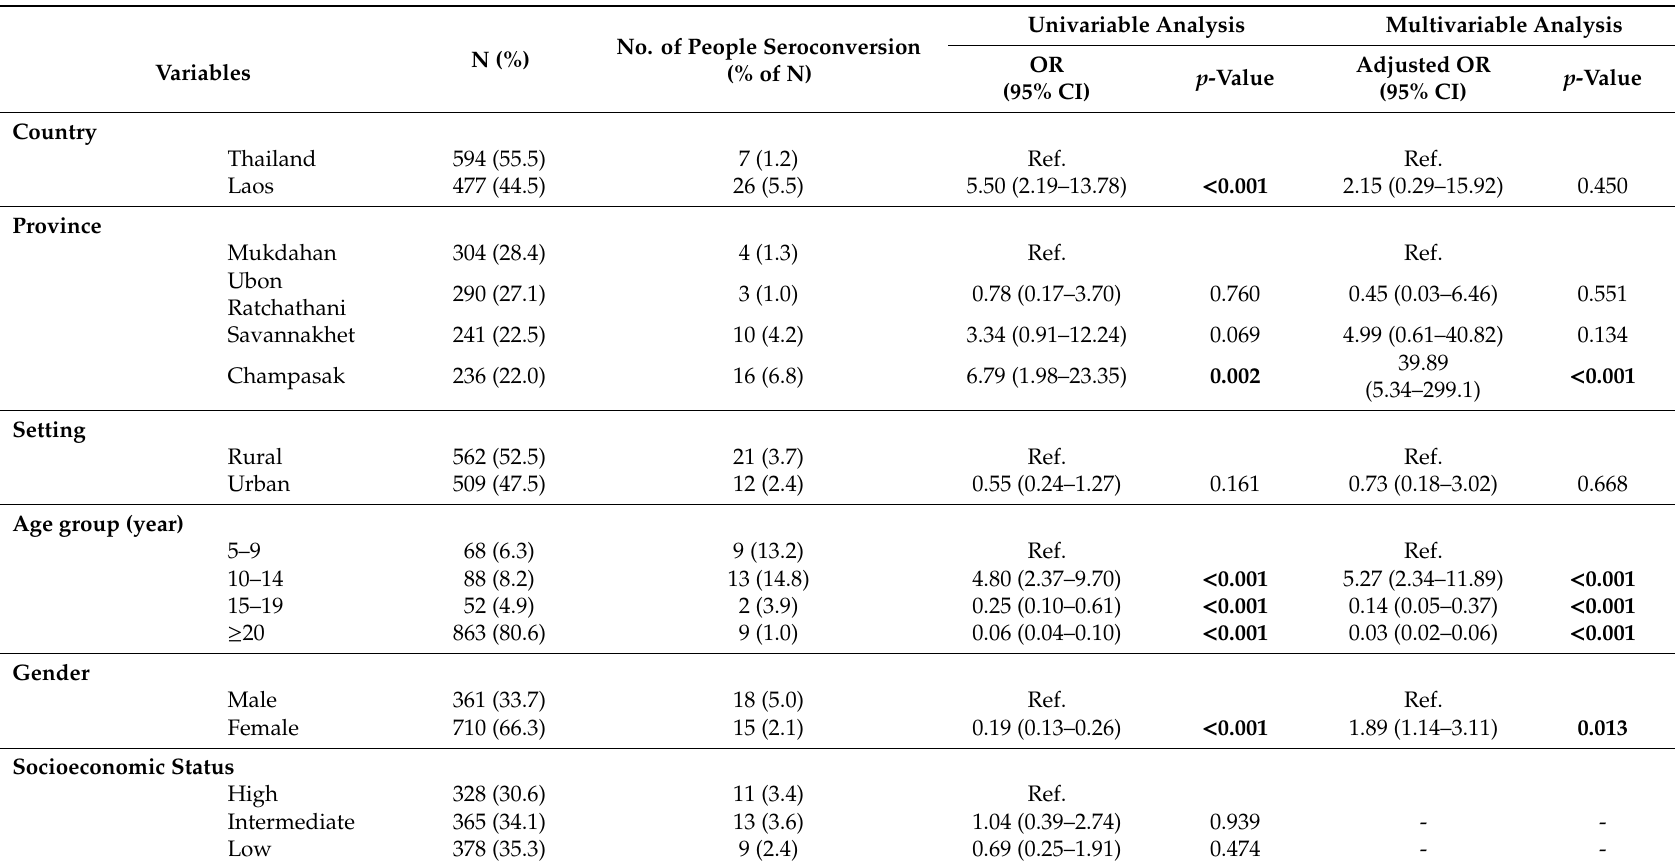
Table 3. Risk factors associated with dengue antibody seroconversion between May and November 2019 in Thailand and Laos (N =